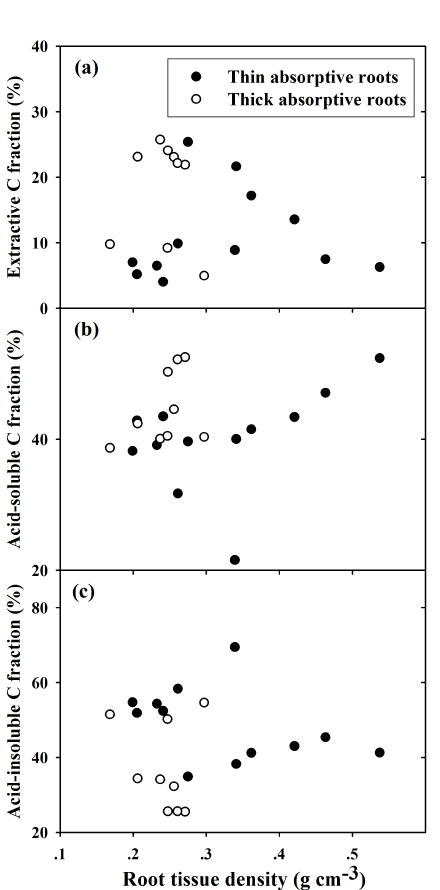
Figure 2. Relationships between root tissue density and extractive C fraction (a) , acid-soluble C fraction (b) , and acid-insoluble C frac- tion (c) , for thin (solid circles) and thick (open circles) absorptive